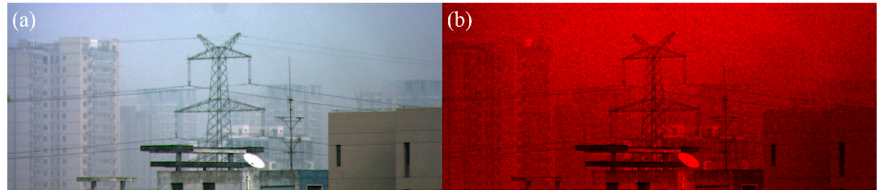
Figure 6. The dehazed images using ( a ) the current proposed method; ( b ) our previously proposed method with the fixed bias parameters.